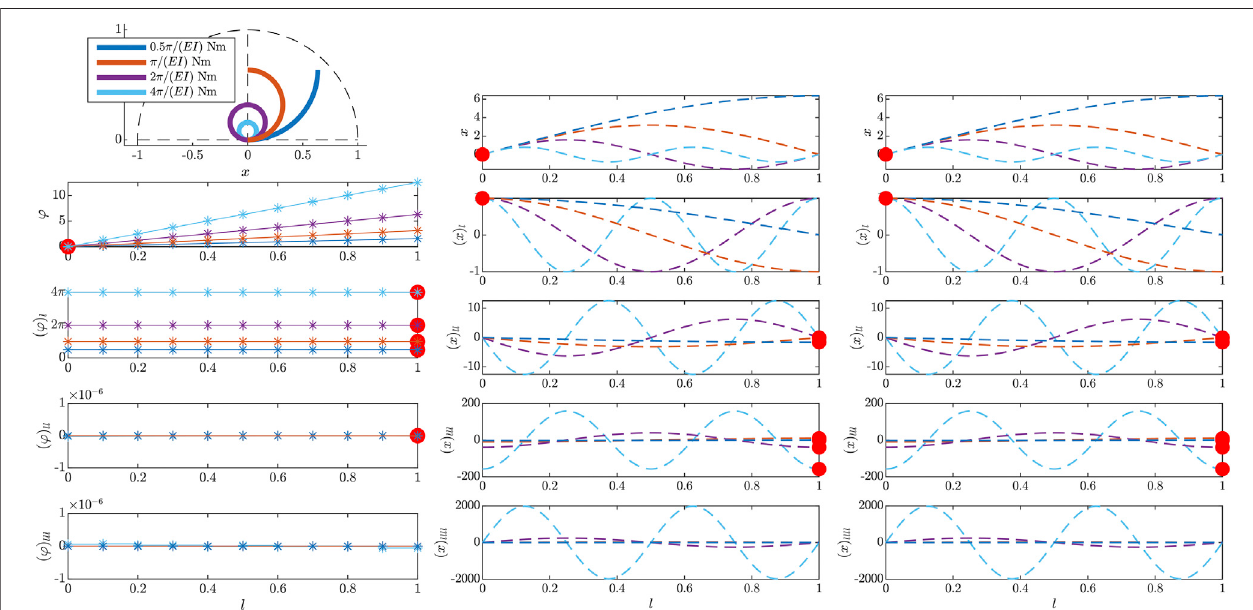
FIGURE 3 | Results of the initial value problem, simulated in the beam tangent angle φ for different external momenta at the free end l (cid:2) L . The results of the actual initial value calculation of φ pro fi les are shown on the left. Additionally, the middle and right columns show the resulting x and y pro fi les (dashed lines). The large red dots mark theimposed boundaryconditionsonthecurvetangentangle pro fi leand theirrespectiveimpactin x and y direction.Note thatthe x and y pro fi les,aswellasthe2D visualization on the top left, are evaluated during postprocessing of the actual simulation results in the curve tangent angle φ , applying the geometric identities Eq. 11 and respective